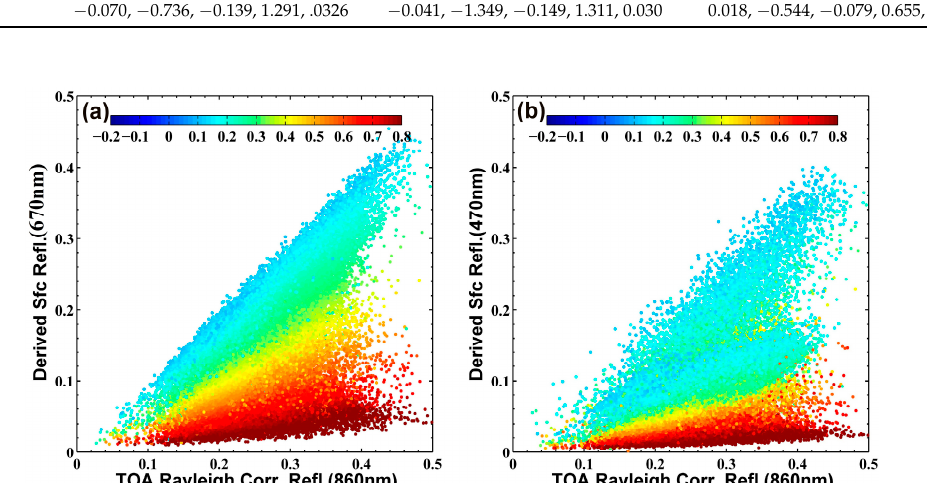
Figure 3. MOD09 surface reflectance at 0.67 µ m ( a ) and 0.47 µ m ( b ) as function of Rayleigh-corrected TOA reflectance at 0.86 µ m and NDVI’ for the summer season. Color bar shows the values of the NDVI’ for each